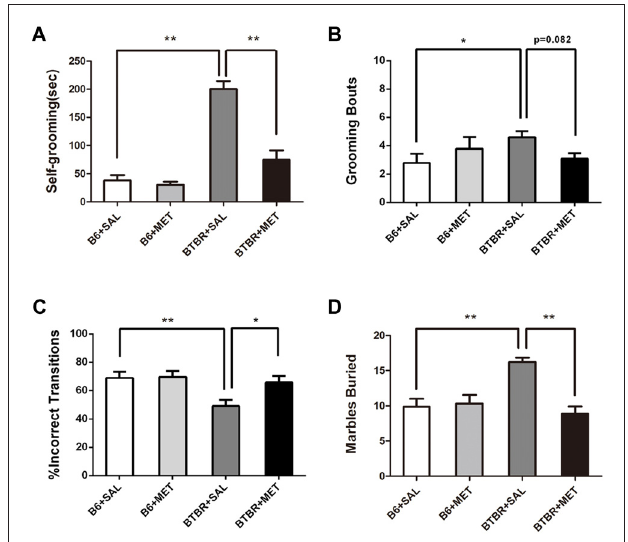
FIGURE 4 | Early metformin treatment rescued the repetitive behaviors in BTBR mice. (A) BTBR mice showed severe repetitive behaviors due to high levels of self-grooming compared to B6 mice, and early metformin treatment can reverse it. (B) Metformin treatment tended to reduce grooming bouts in BTBR mice compare with saline-treated BTBR mice, the effect approached statistical significance. (C) BTBR mice showed decreased proportion of incorrect transitions compared to B6 mice, and metformin treatment increased it. (D) BTBR mice buried more marbles compared to B6 mice, and metformin treatment can reverse it. Data are presented as the means ± SEM. n = 10. ∗ P < 0.05, ∗∗ P < 0.01.